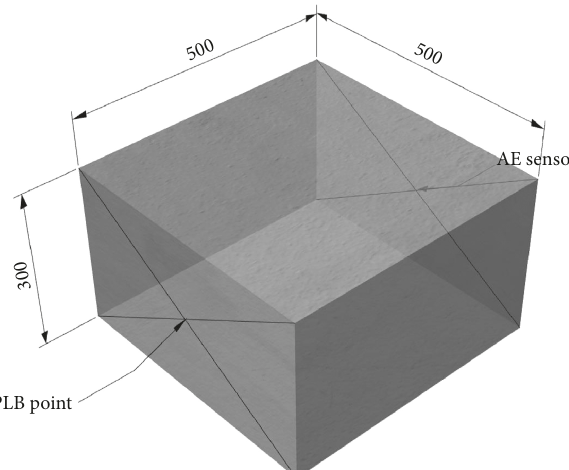
Figure 6: Schematic diagram showing the locations of the lead- break point and AE sensor. Table 4: The rise-time data recorded in the PLB tests. Block